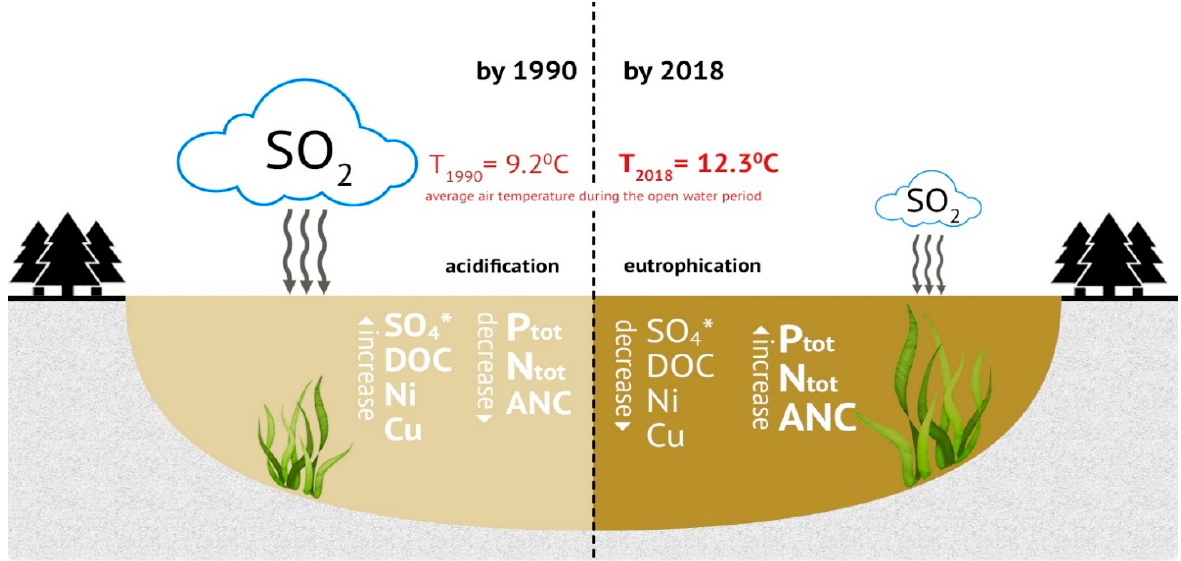
Figure 7. Scheme of the development of lakes from acidification to eutrophication in the Arctic region under the influence of reduced acid deposition and climate warming.